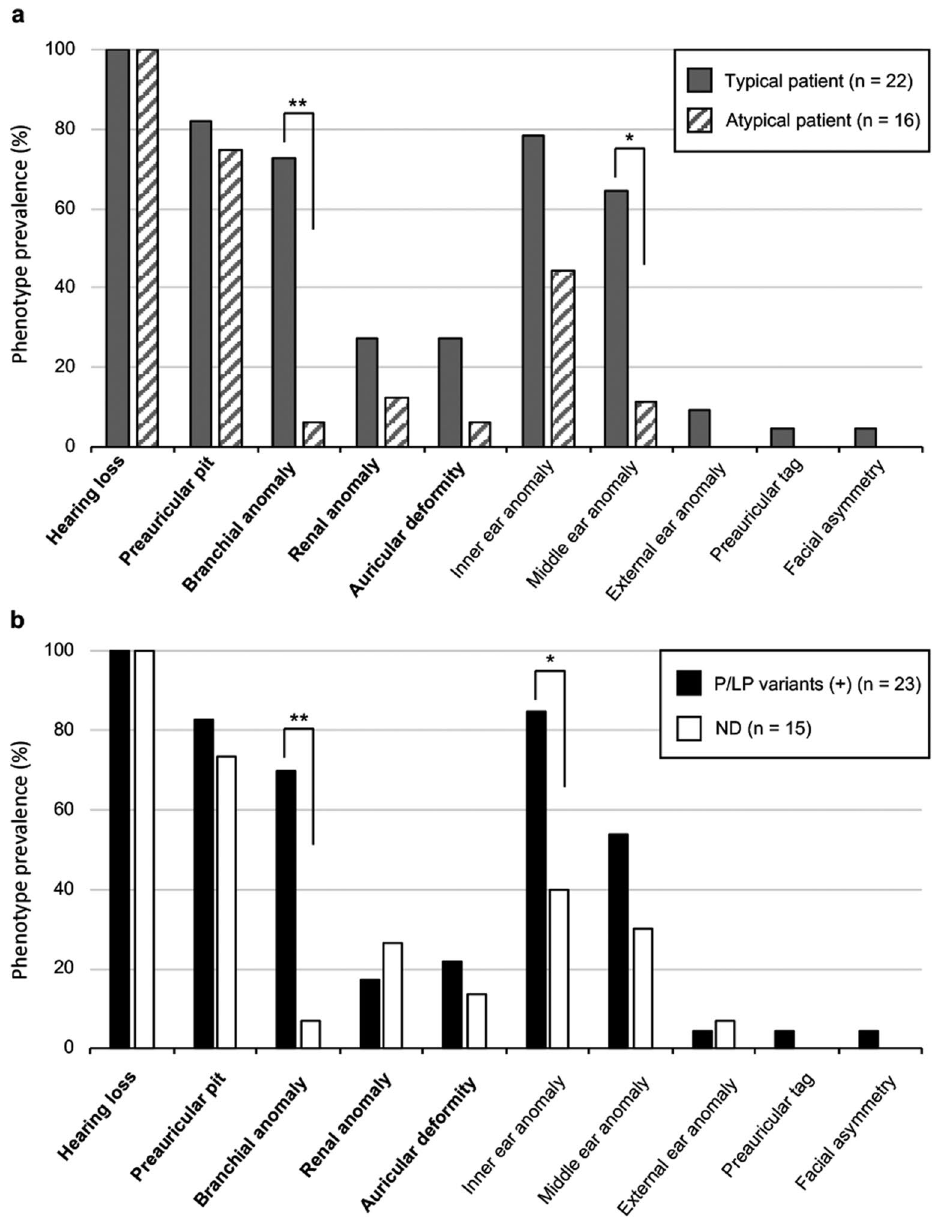
Figure 4. Prevalence rates of phenotypes in patients. ( a ) Patients with typical or atypical BOR syndrome. ( b ) Patients with or without P/LP variants of EYA1 . Significant difference at **p < 0.01 and *p < 0.05, respectively (Fisher’s exact